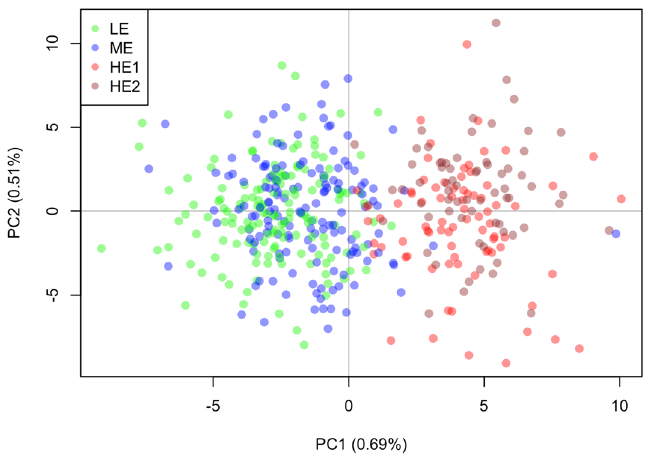
Figure 2. Principal component analysis, PC1 and PC2 are plotted. Each dot represents genotyped individual; explained variance for each PC in the brackets.